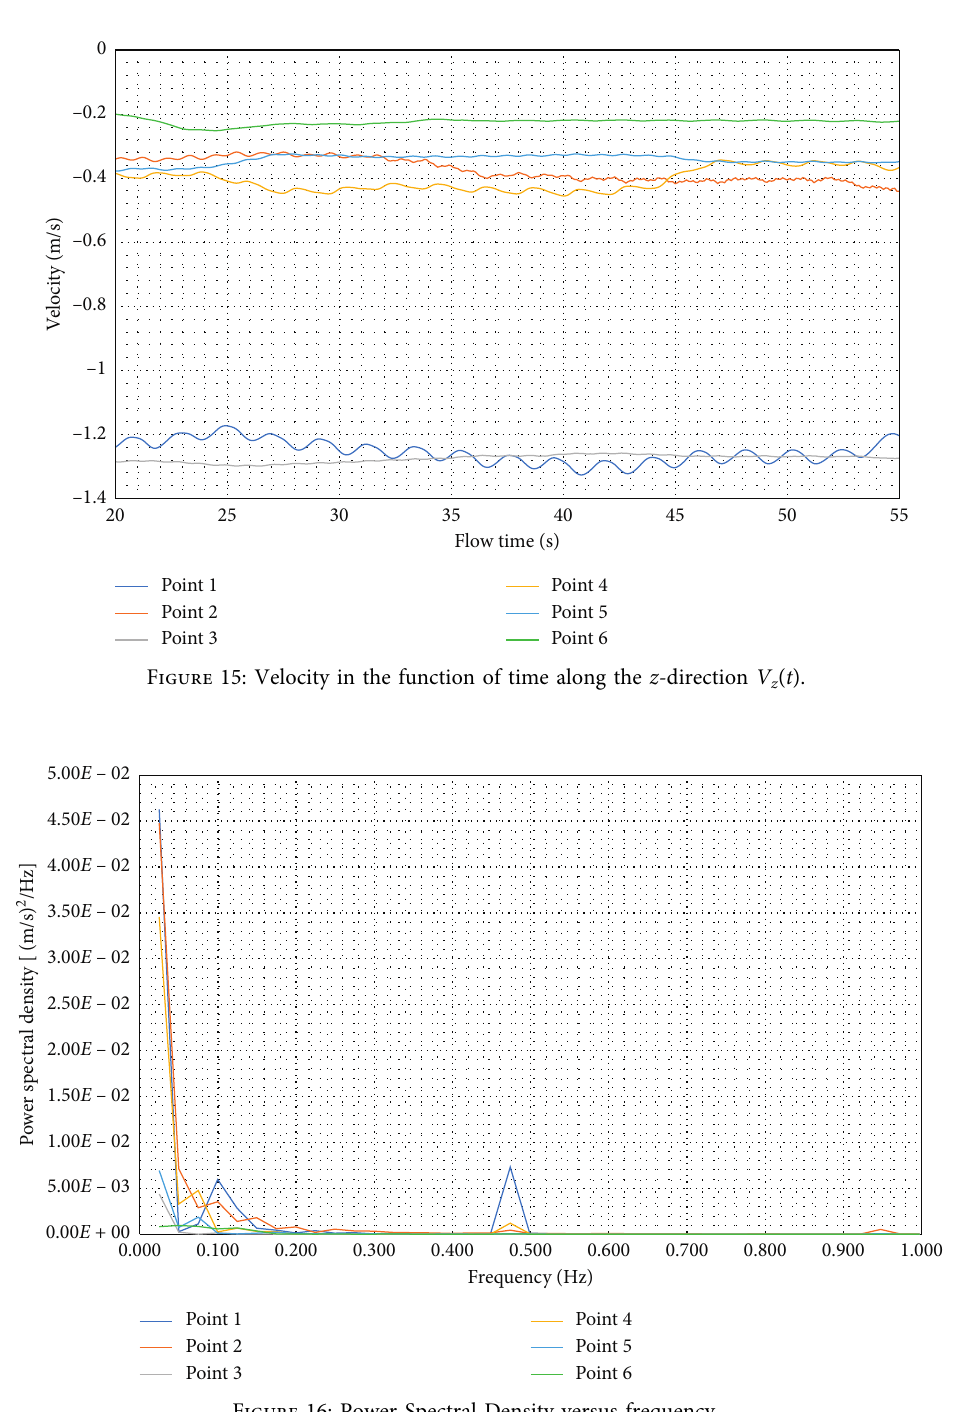
Figure 16: Power Spectral Density versus